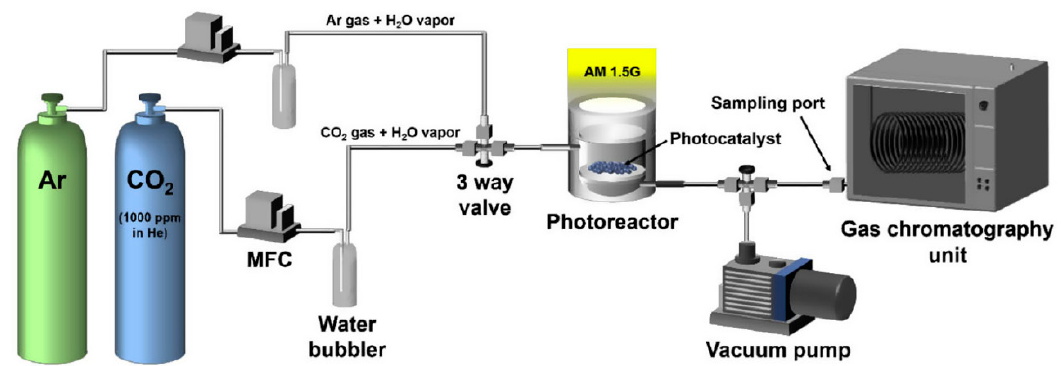
Figure 5. Setup for continuous gas phase photocatalytic CO 2 reduction, reproduced with permission from reference [11]. Copyright Elsevier, 2017.